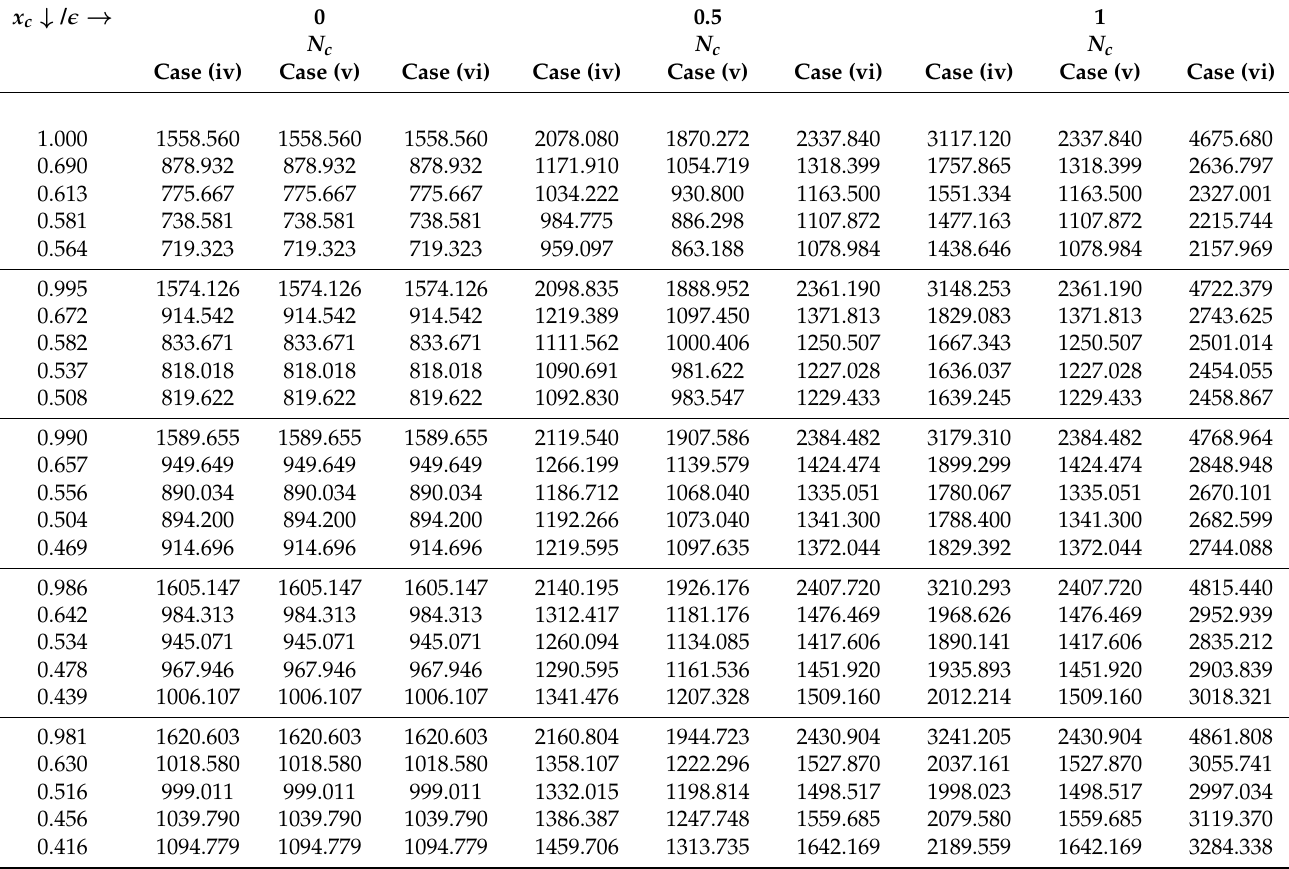
Table 6. N c for the cases (iv), (v), and (vi), for different values of x c and (cid:101)